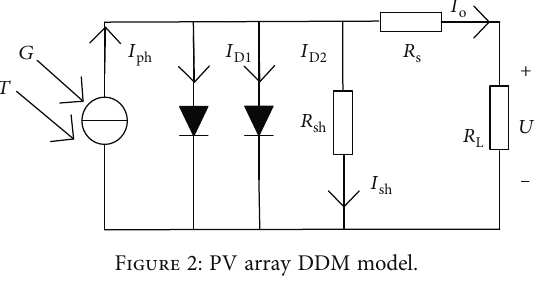
Figure 2: PV array DDM